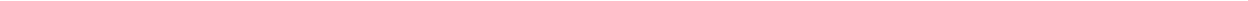
Fig. 2 Properties of light response in isolated rd1 mouse retina with SNAG-mGluR2 in RGCs. a (top) Average response of RGC population showing peak inhibition (1) and OFF response following light termination (2). (bottom) Averaged raster plot ( n = 134) 5 × 3 s duration with 472 nm light fl ashes. b BGAG 12,460 stable for weeks in solution. No signi fi cant difference in peak responses between SNAP-mGluR2 expressing rd1 retinas labeled with freshly solubilized BGAG 12,460 ( n = 58 cells) vs. BGAG 12,460 stored in aqueous solution for 4 weeks ( n = 46) ( N = 2). c BGAG 12,460 labeling responses appear maximal at 5 µ M when bathing retina for 45 min and 500 nM when injected intravitreally in vivo 24 h before retinal isolation ( n > 50 units per retina, N = 14). Low done behavioral experiments performed at concentration indicated by red square. d , e Time-course of light response. Population average traces with time from light onset to max inhibition ( d ), exponential fi t for OFF response decay (red) and time from light termination to max excitation ( e ). n = 109 and 95, N = 2. Time to peak of wt OFF responses also measured for comparisons n = 63, N = 2. f Light sensitivity for SNAG-mGluR2 in RGCs of rd1 mouse retina. Peak fi ring rates normalized for inhibition (open circle) and OFF response (closed circle). ( n = 100, N = 2). Behavioral experiments performed at intensity indicated by red square. g , h Dependence of response on fl ash duration. g Representative retina light response ( n = 75): individual cell response raster plot (top) and population average fi ring rate (bottom). ± SEM reveal detectable responses down to 25 ms duration fl ashes. h Average peak inhibition (open circle) and OFF response ( fi lled circle) for different stimulation durations ( n = 139, N = 2). i , j SNAG-mGluR2 enables RGCs to follow light pulses at up to 8 Hz. j Average peak inhibition ± SEM (open circle) and OFF response ( fi lled circle) for different frequencies with either equal duration light pulses and dark intervals (0.5 – 5 Hz: 1 s light/1 s dark – 100 ms light/100 ms dark) or fi xed duration (50 ms) fl ashes with varying dark intervals (4 – 10 Hz) ( n = 120, N = 2). Light intensity 25 or 50 mW cm − 2 , Wavelength: λ = 445 nm, BGAG μ M unless otherwise 12,460 labeling after retinal isolation for 45 min at 50 speci fi ed. N = # of retina, n = total units/cells. All units refer to sorted cells. SEM in gray or as error bars. Statistical signi fi cance assessed using Mann – Whitney U test (* p ≤ 0.001) (Supplementary Table